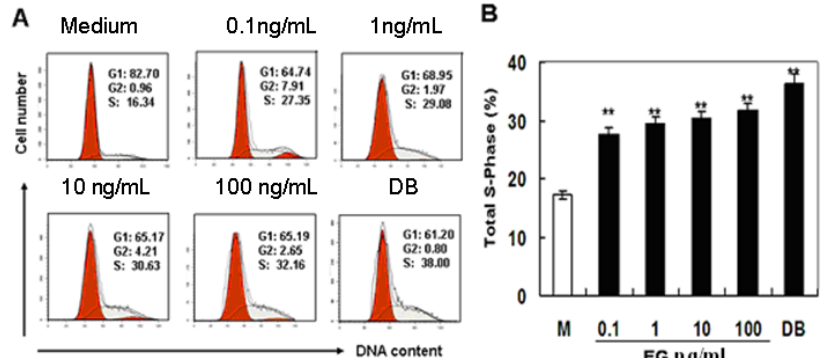
Figure 3. EG promotes cell cycle progression in MC3T3-E1 cells.